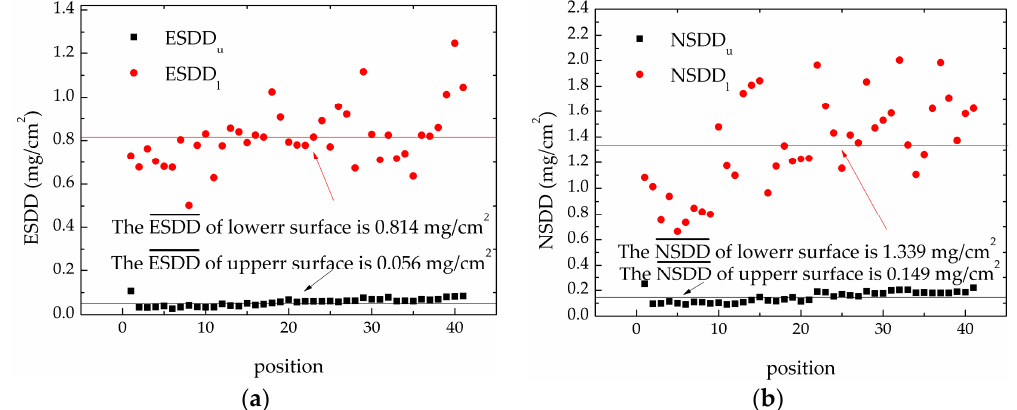
Figure 9. The contamination of High Voltage Altanating Current (HVAC) insulators. ( a ) The results of ESDD. ( b ) The results of NSDD.